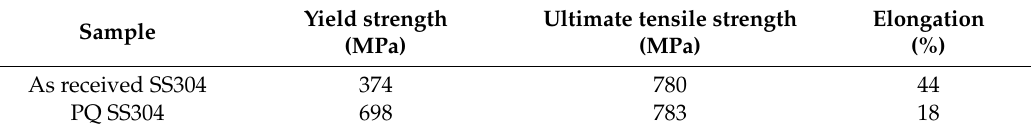
Table 3. Tensile test results.